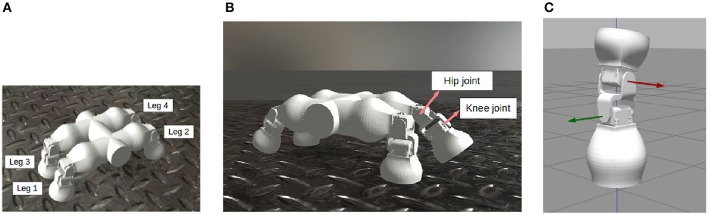
The Fable Robot in the Neurorobotics Platform (NRP). The robot has 4 legs (A) and 2 revolute joints per leg (B) which rotate around 2 perpendicular axes (C) (Pacheco et al., 2014; Falotico et al., 2017).